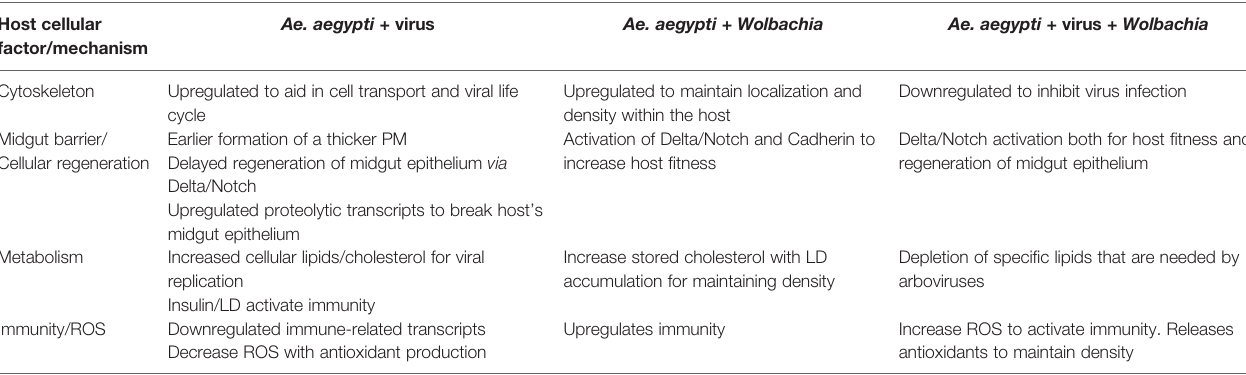
TABLE 3 | Summary of interactions between Ae. aegypti- Arboviruses- Wolbachia . Host cellular